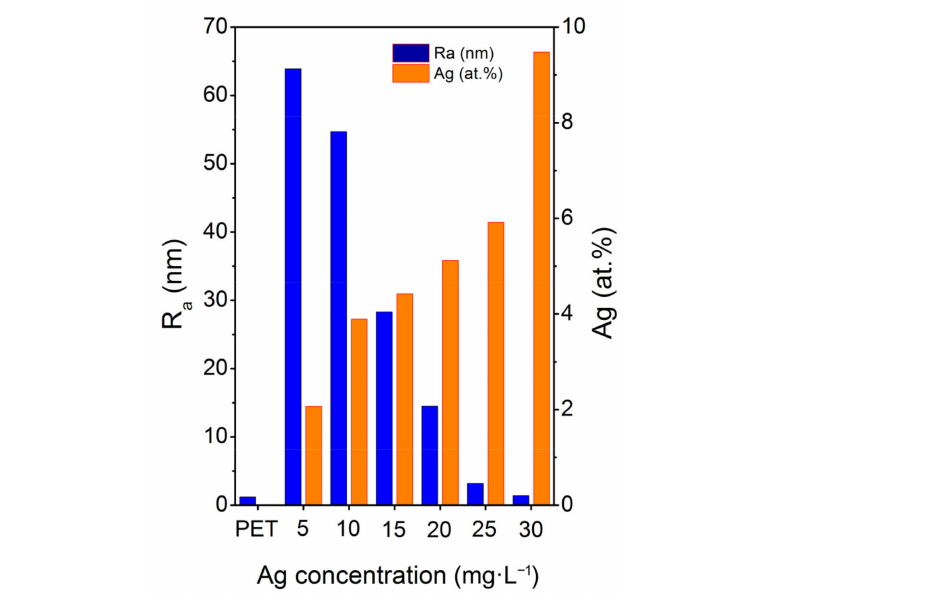
Figure 4. Average surface roughness (Ra) and atomic concentration of silver determined by XPS as a function of the Ag concentration in the immobilization solution.